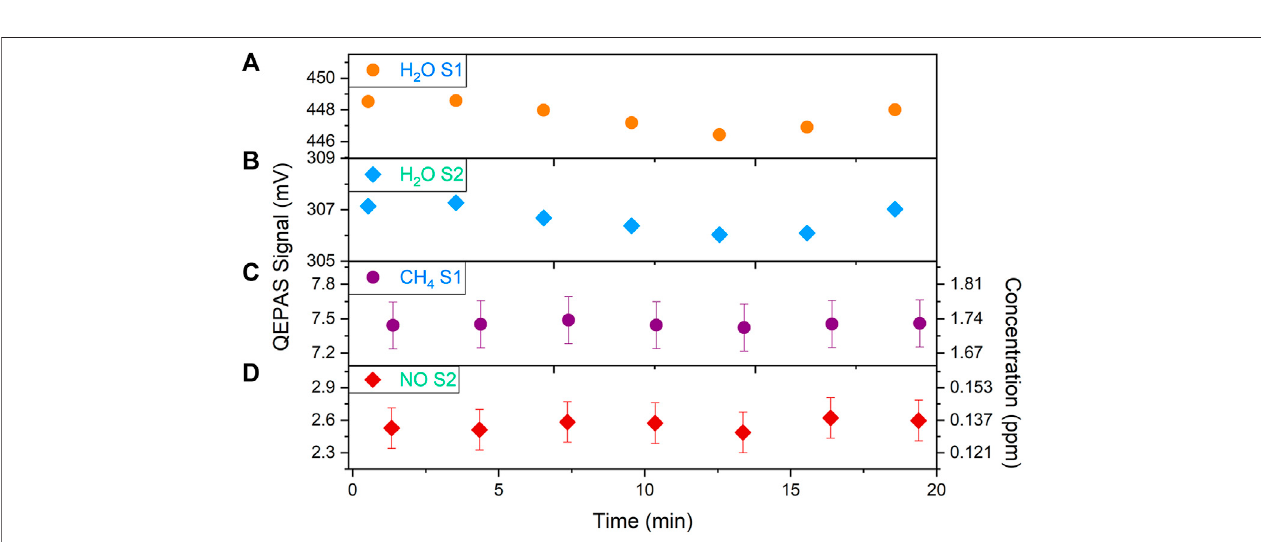
FIGURE 10 | QEPAS peak signals extracted by consecutive QEPAS spectra acquired by sampling the air inside the laboratory. Sensor S1 was used to target (A) H 2 O(orangedots) and (C) CH 4 (purpledots),whilesensorS2wasused totarget (B) H 2 O(cyandiamonds)and (D) NO(reddiamonds).Theerrorbars correspond tothe noise fl uctuations.